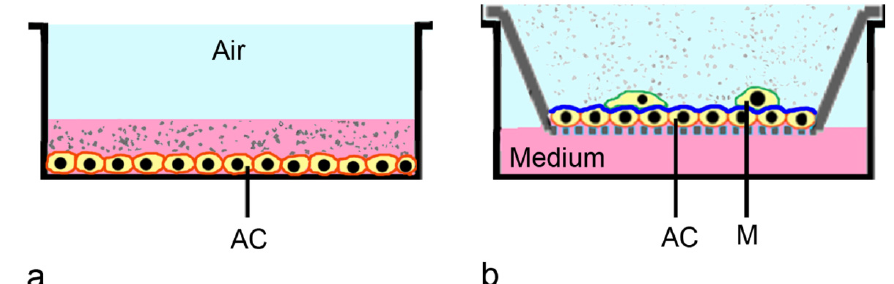
Figure 3. Exposure of alveolar cells in submerged culture and exposed to nanoparticle suspensions ( a ), and cultured in air-liquid interface exposed to nanoparticle-loaded aerosol ( b ). ( a ) Alveolar cells (AC) cultured in submersed culture usually do not differentiate and lack mucus or surfactant. NPs suspended in medium often form aggregates; ( b ) (co-culture shown): Alveolar cells cultured on transwells in the air-liquid interface produce surfactant (blue). NPs in aerosols usually form smaller aggregates than nanoparticles in suspensions. For further refinement of the model, co-culture with macrophages (M) on top of the epithelial cells ( b ) can be